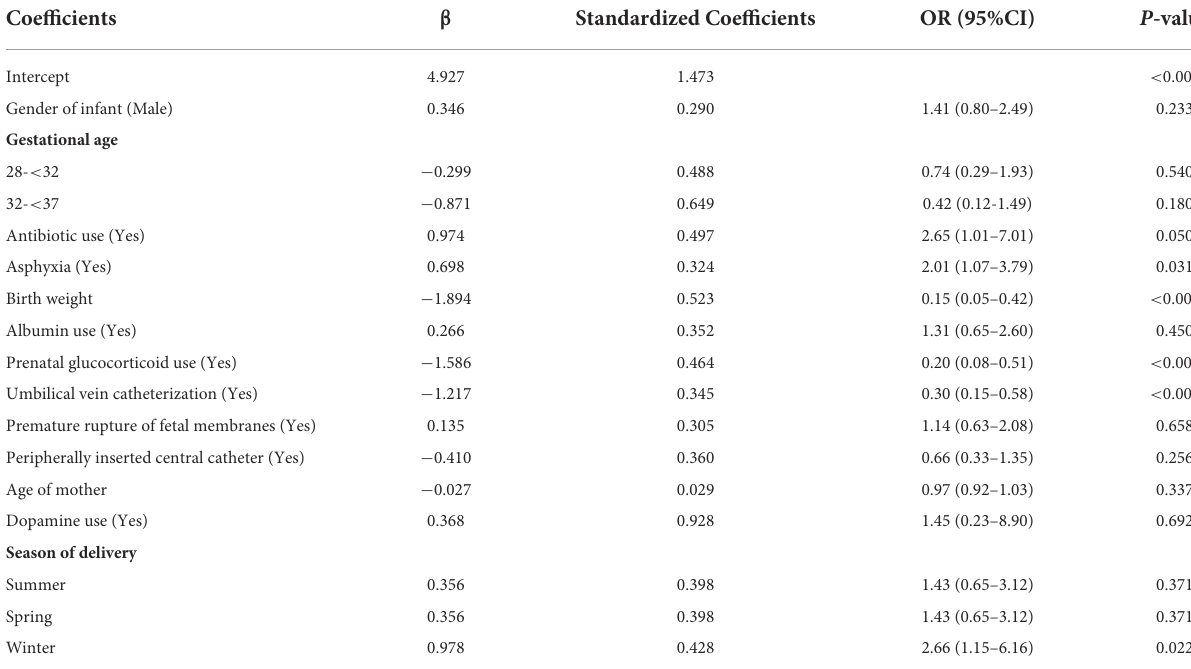
TABLE 4 Construction of the prediction